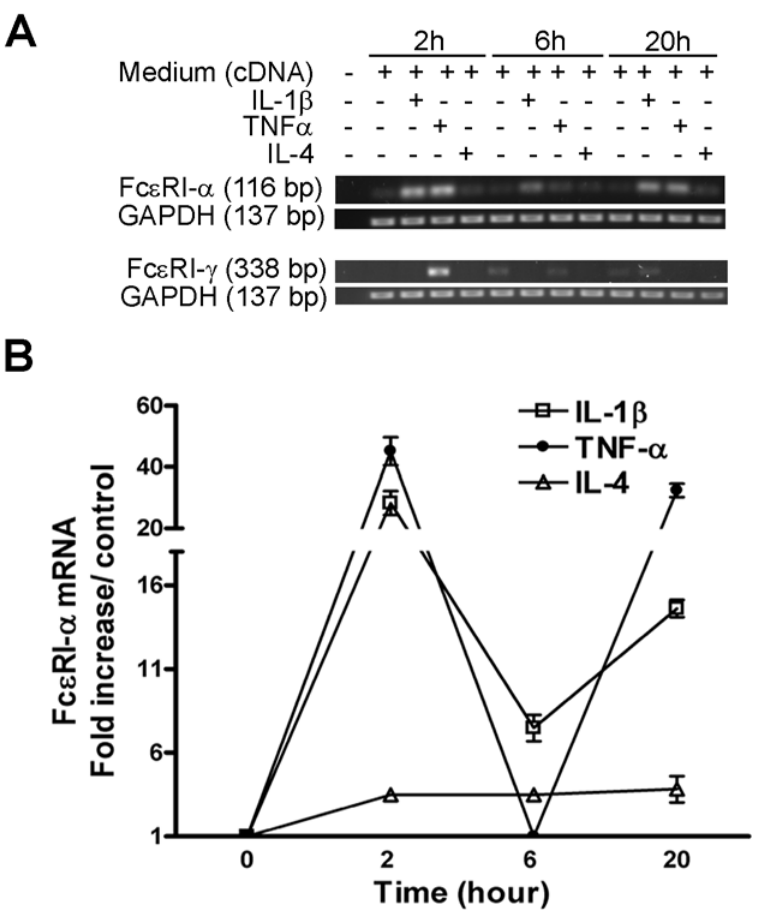
Figure 1. Proinflammatory and Th-2 cytokines upregulate the Fc e RI mRNA expression in human B/TSM cells. Human B/TSM Fc e RI- a and – c mRNA expression was analysed by (A) RT-PCR and (B) by Real-time RT-PCR for Fc e RI- a chain. GAPDH was used as internal control for (A) and to normalize the Fc e RI- a copy number for (B) as described in Materials and Methods . Each data point (except for TNF- a at 6 h) represents a significant (p , 0.05, n=3) increase in copy no. over unstimulated control. P values were calculated using Mann Whitney U